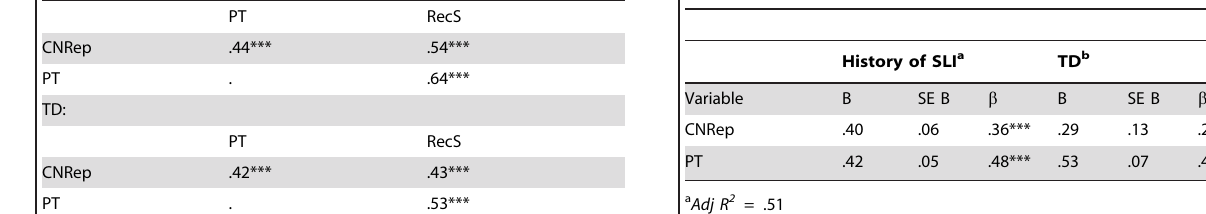
Table 5. Multiple regression analysis modelling memory and morphology as predictors of recalling sentences raw score in children with a history of SLI and TD